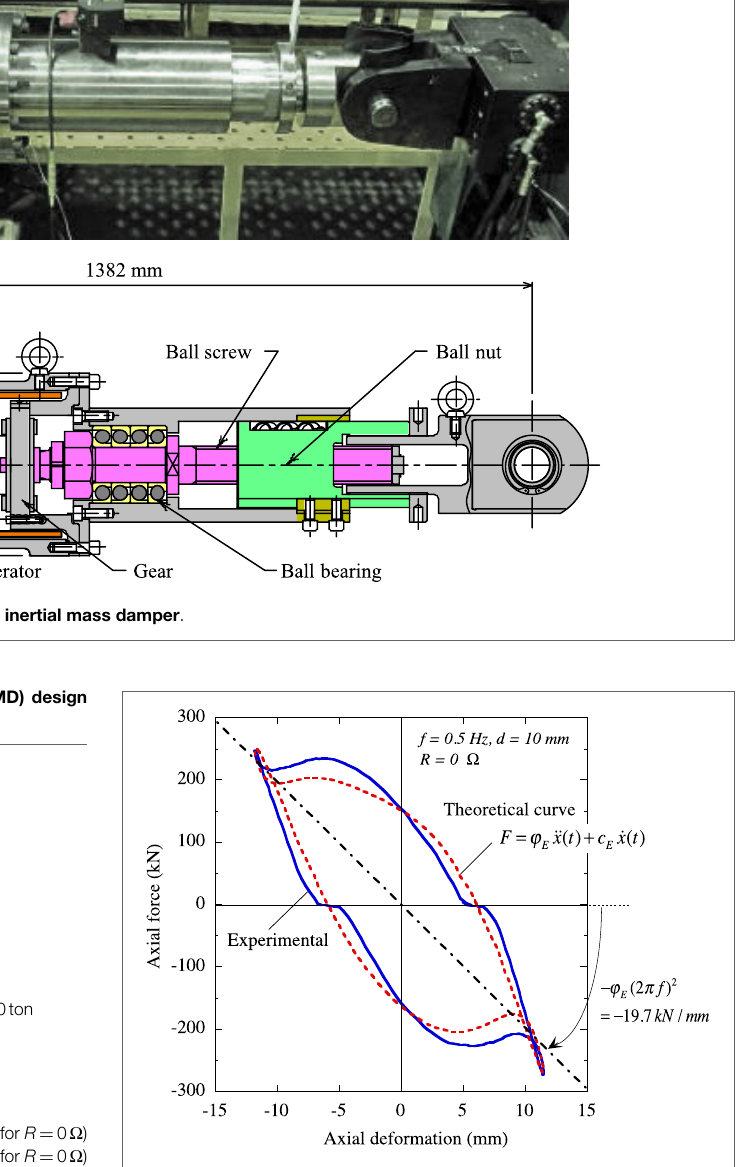
FIGURE 3 | Full-size electromagnetic inertial mass damper resisting force characteristics .